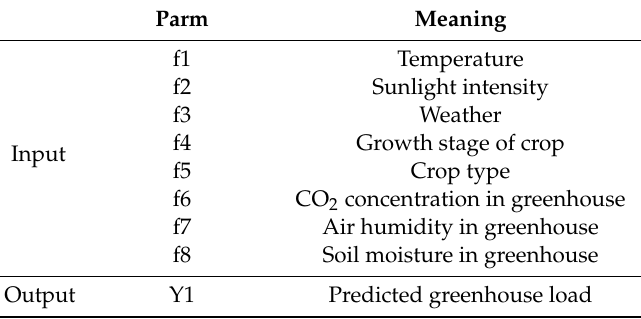
Table 2. Sample data of agricultural load